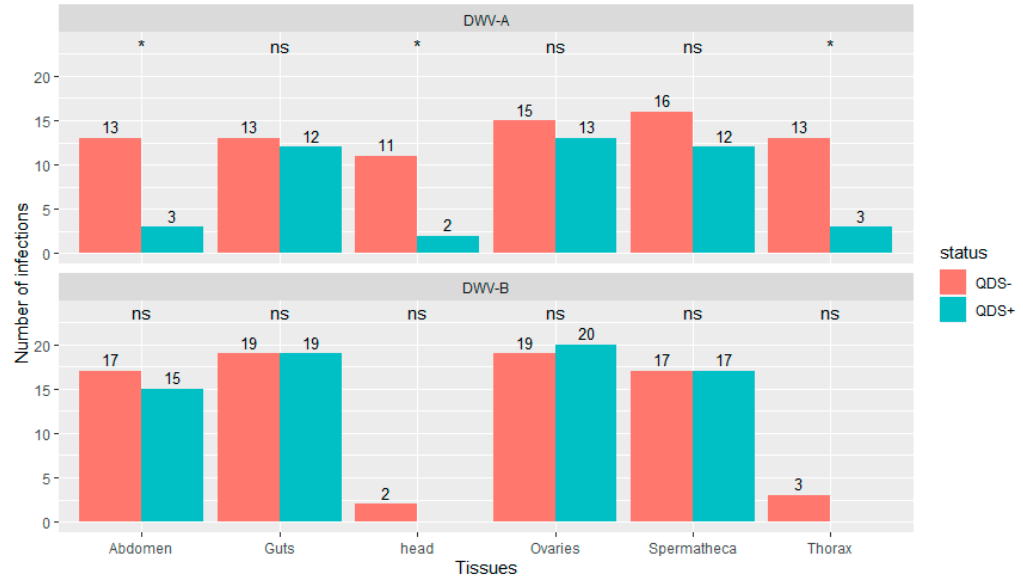
Figure 2. Number of tissues infected with DWV-A or DWV-B. Data is presented for QDS+ (green) and QDS– (red). Each group consists of 20 dissected queens. Significant differences between both groups are indicated at the top of each tissue with *, non-significant differences with ns.